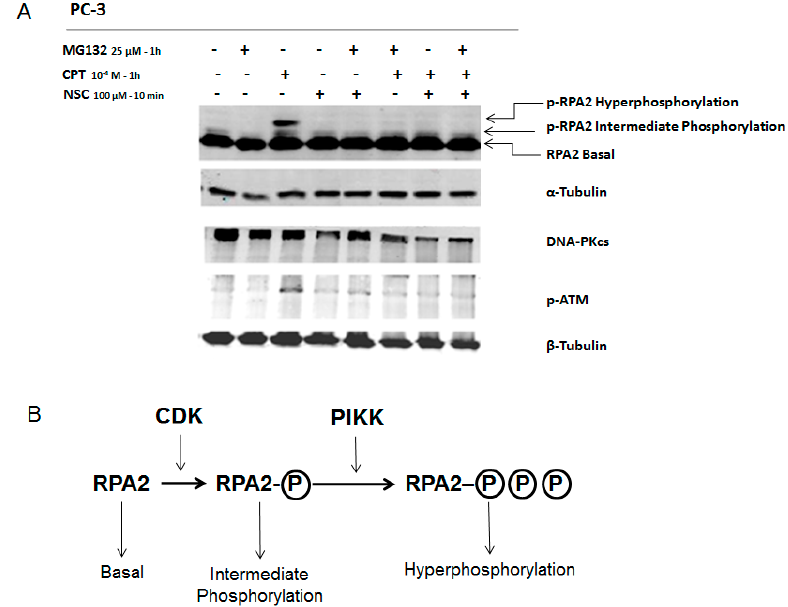
Figure 5. Response of DNA-PKcs and ATM to exposure to NSC and proteasome inhibitor MG-132 in CPT-treated PC-3 cells. ( A ) Serum-starved cells were incubated with 10 − 4 M CPT alone for 20 h and further exposed to NSC (100 µM for 10 min) or MG132 (25 µM for 1 h) alone or successively to the two compounds. Two phosphorylated forms of RPA2 are indicated; hyperphosphorylated and intermediate phosphorylated, which present high and middle bands, respectively. α -Tubulin